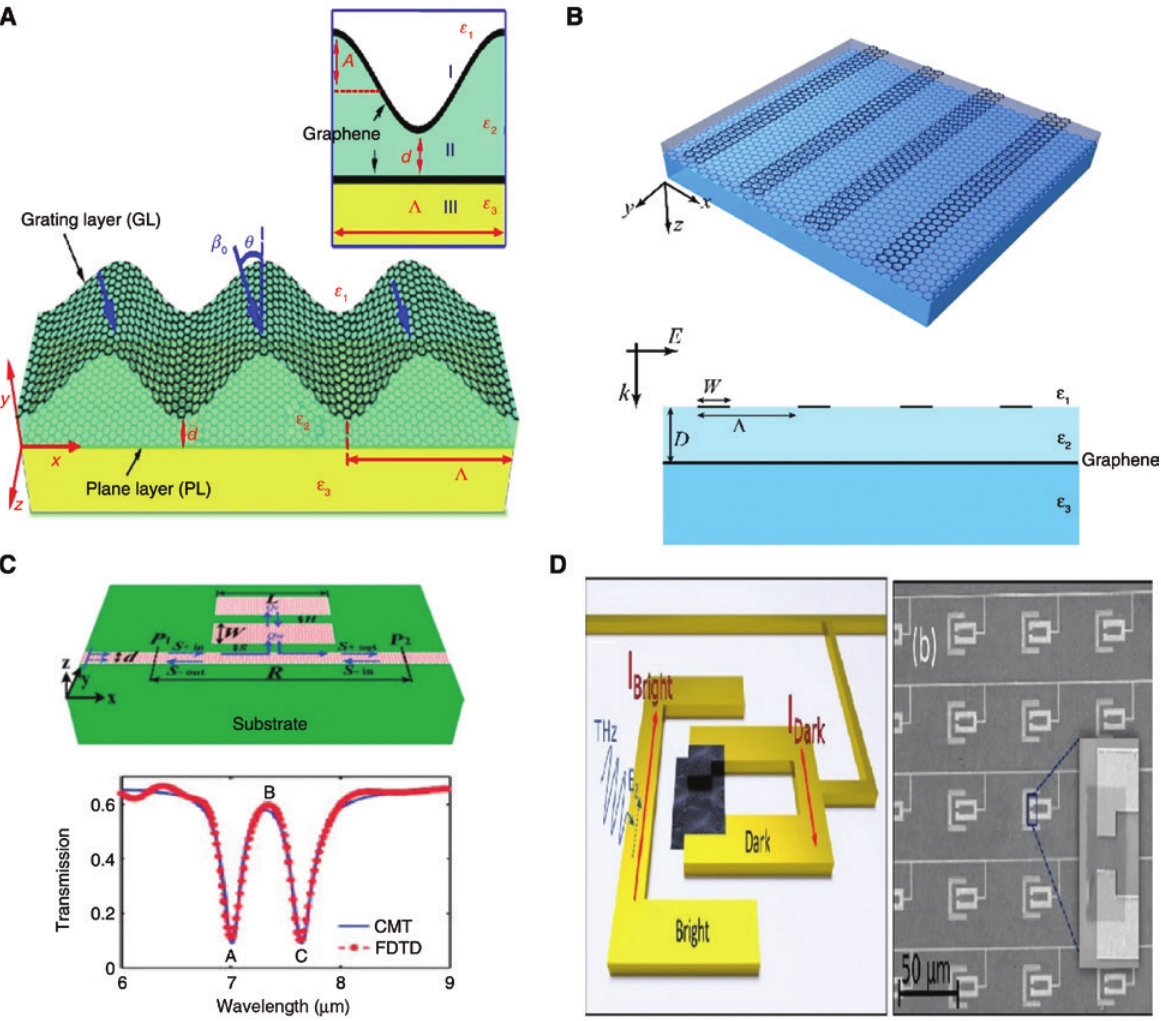
Figure 4: Graphene layers work as building blocks for constructing PIT structures. (A) Sinusoidal curved and planar graphene layers separated by a dielectric spacer. The height of the dielectric spacer determines the coupling strength between the two graphene layers [95]. (B) An active PIT system based on graphene grating sheet near-field coupling mechanism. The PIT effect is based on the near-field coupling between localized plasmon resonances of graphene nanostructures. The thickness of dielectric spacer can be optimized to more than 100 nm [96]. (C) Graphene waveguide side coupled with two